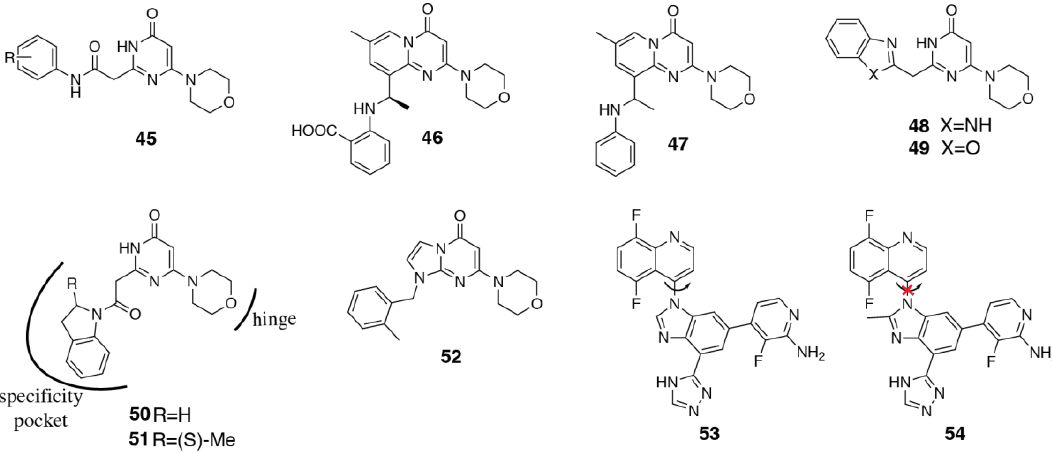
Figure 9. Structures of PI3K selective inhibitors 45 – 54 . In the structure of 53 , there is free rotation around the bond highlighted with an arrow. The addition of a methyl group at the 2-position of the benzimidazole ring in 54 restricts rotation, thus forming two atropisomers.